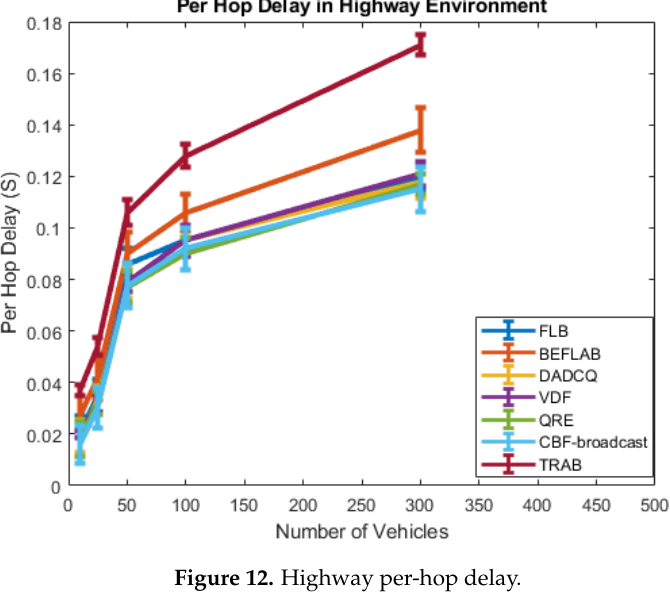
Figure 12. Highway per-hop delay.